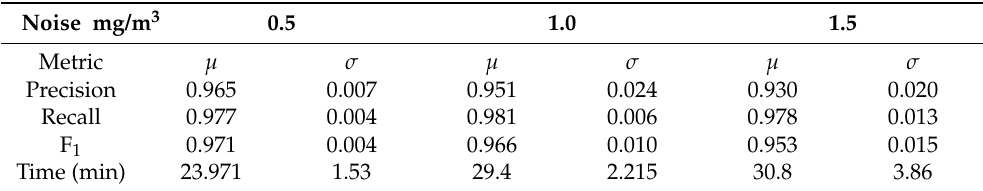
Figure 8. TThis diagram represents the red zone estimation of the Corridor pollution scenario performed using the BREEZE approach with a Gaussian noise of 0.5 mg/m 3 . The grey cells are ground truth, the red cells are True-Positive, the green cells are False-Positive, and the blue cells are obstacles. Table 3. The data gathered in the Corridor scenario for three different noise levels (0.5, 1.0, and 1.5 mg/m 3